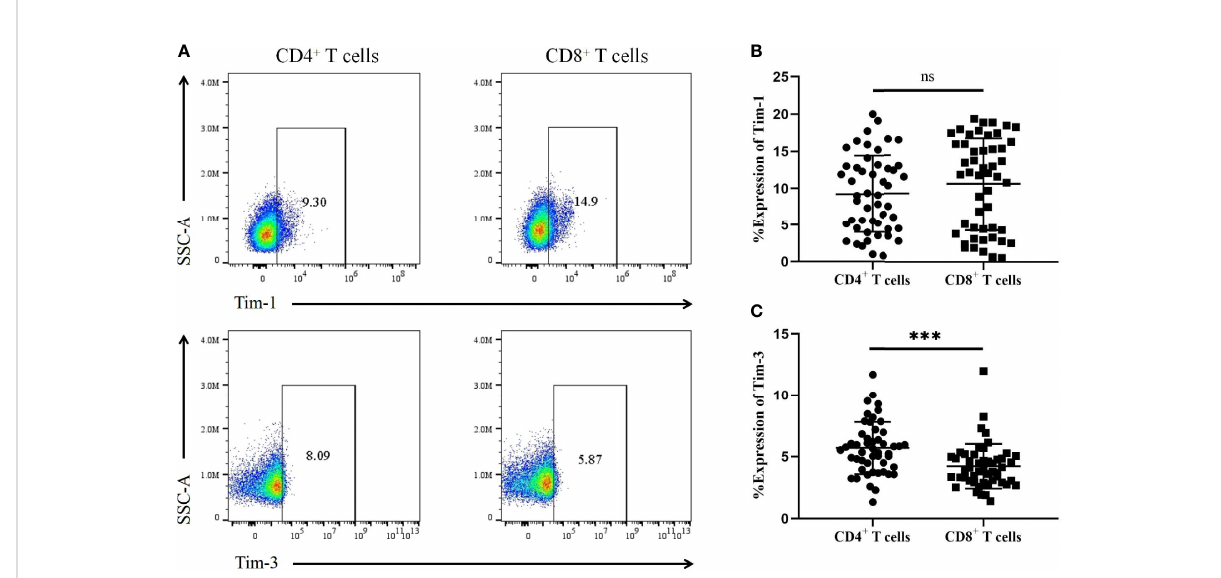
FIGURE 4 The expression of Tim-1 and Tim-3 in different T-cell subsets from T1D patients. (A) Representative plots showing the expression of Tim-1 and Tim-3 in different T-cell subsets. (B) The expression of Tim-1 on CD4 + and CD8 + T cells in T1D patients. (C) The expression of Tim-3 in CD4 + and CD8 + T cells in T1D patients. ns, no statistical difference; *** P <0.001.